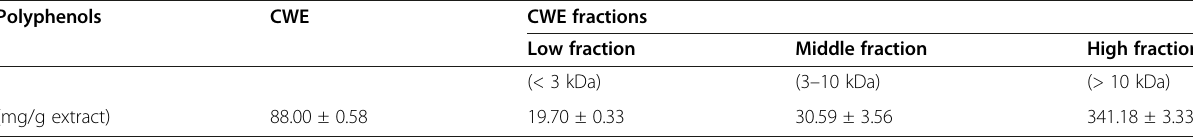
Table 1 Total polyphenols in CWE and its size-based fractions Polyphenols